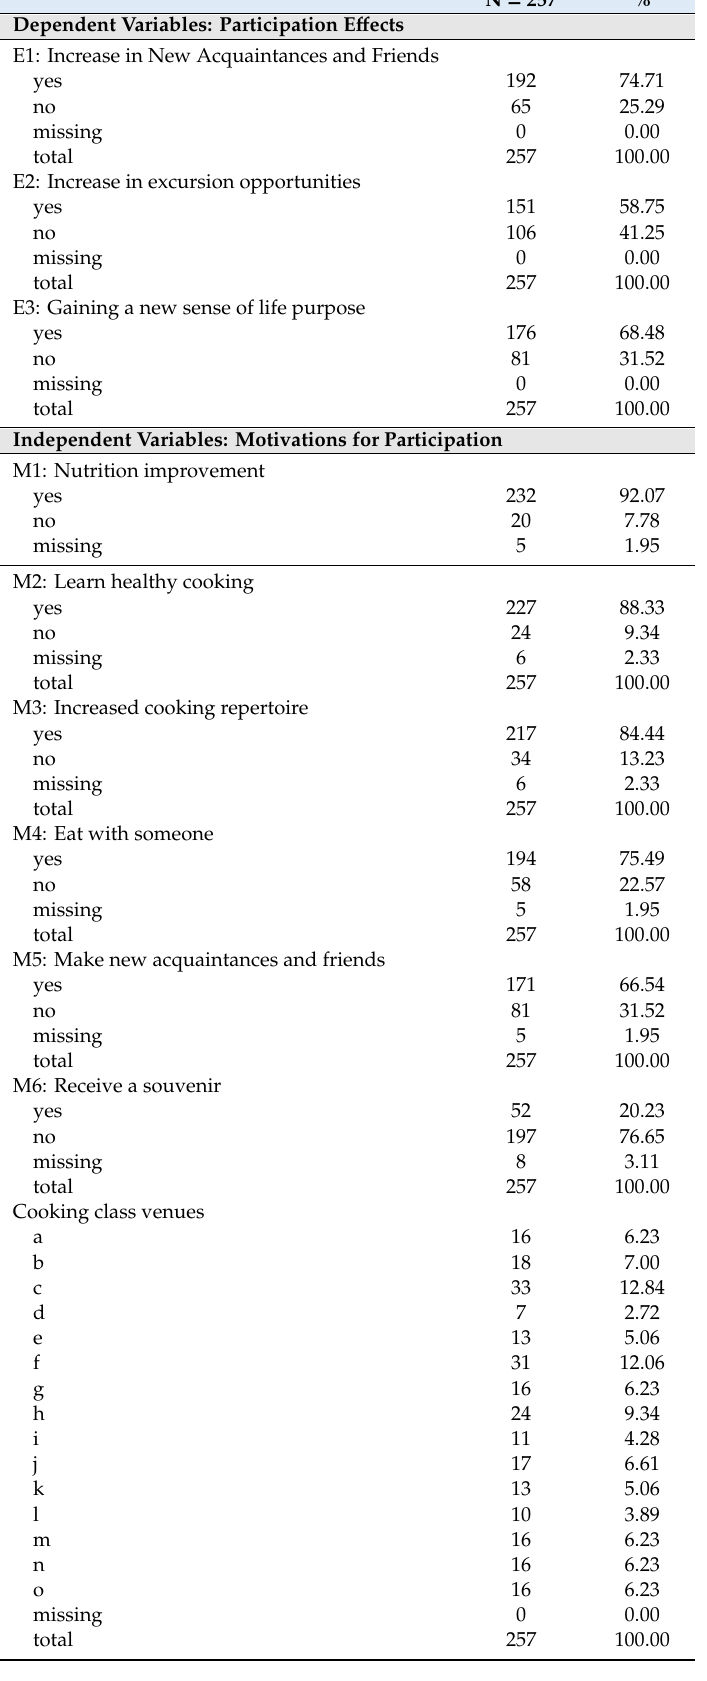
Table 1. Characteristics of